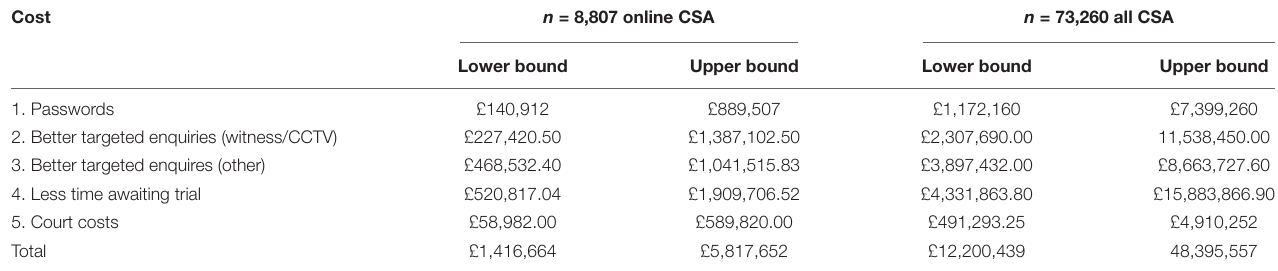
TABLE 10 | Projected cost savings attributable to predominant use of adaptive cooperative interviewing.